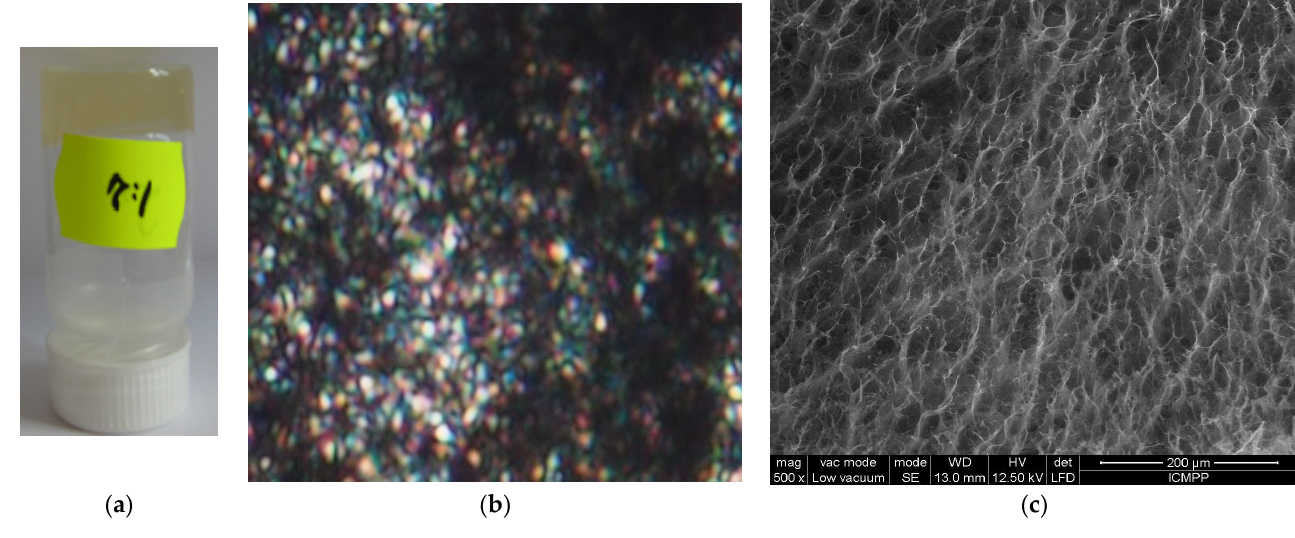
Figure 2. Representative images of the ( a ) hydrogels, ( b ) POM texture, and ( c ) SEM microstruc-